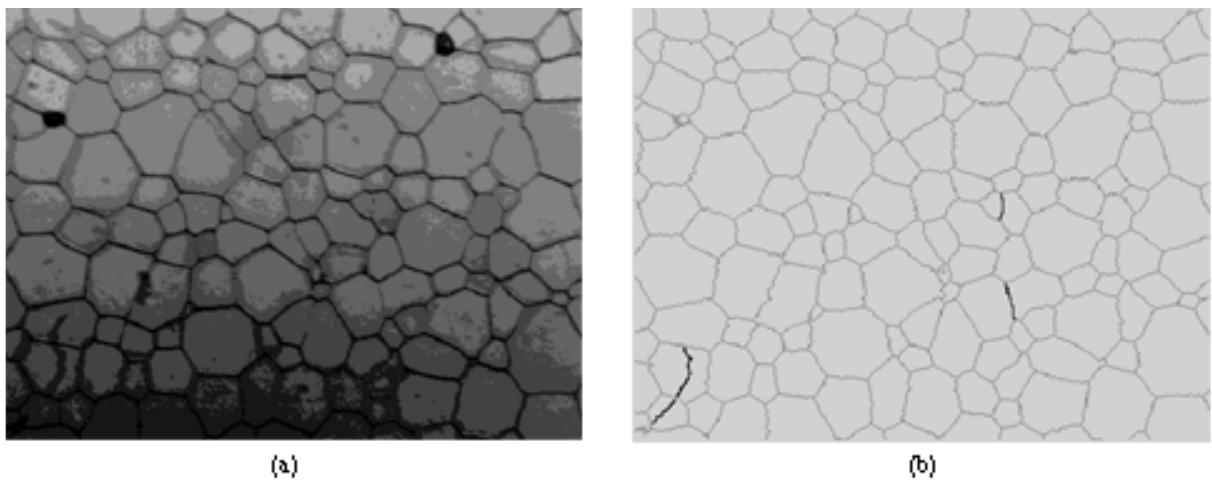
Figure 7. ABA transform segmentation for three uranium oxide samples: (a), (c) and (e) are original noisy images, (b), (d) and (f) are ABA transform segmented